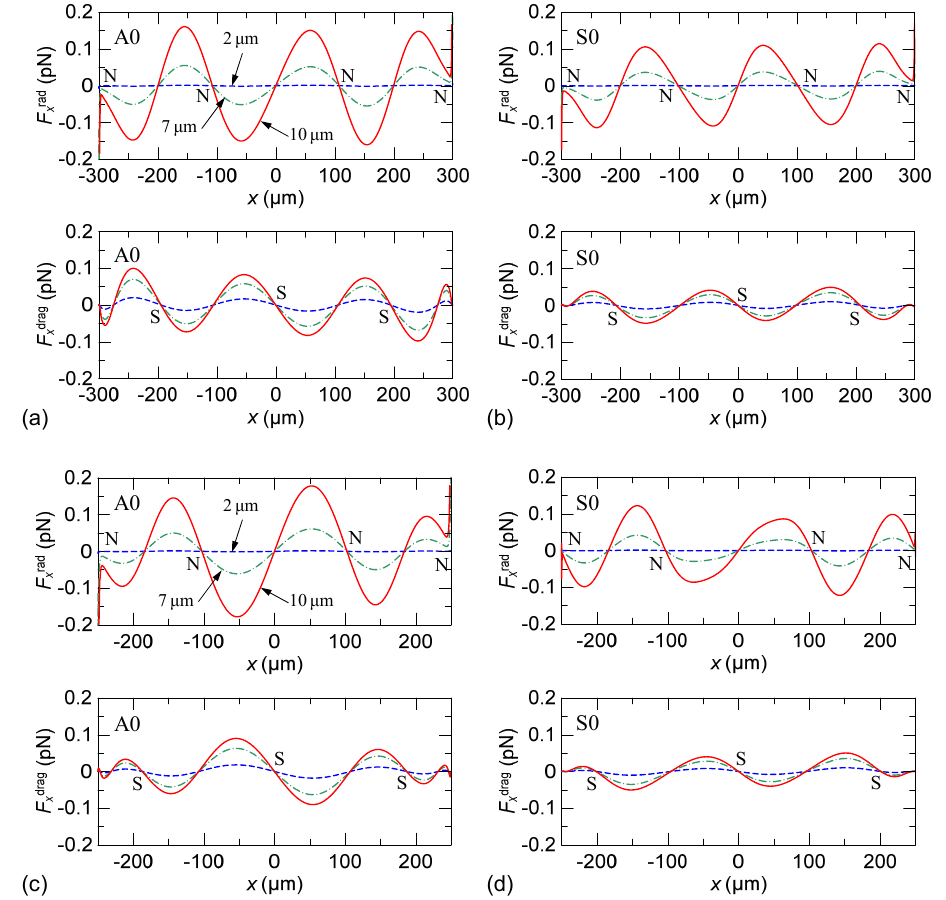
Figure 8. Calculated horizontal component of the acoustic radiation force F x rad and Stokes drag force F x drag with respect to particles of different sizes ( d = 2, 7, and 10 μ m) along the channel width at an altitude of 40 μ m from the channel bottom. ( a ) A0 mode, w = 600 μ m; ( b ) S0 mode, w = 600 μ m; ( c ) A0 mode, w = 500 μ m; ( d ) S0 mode, w = 500 μ m. In the figure, N and S denote pressure nodes and streaming stagnation points,